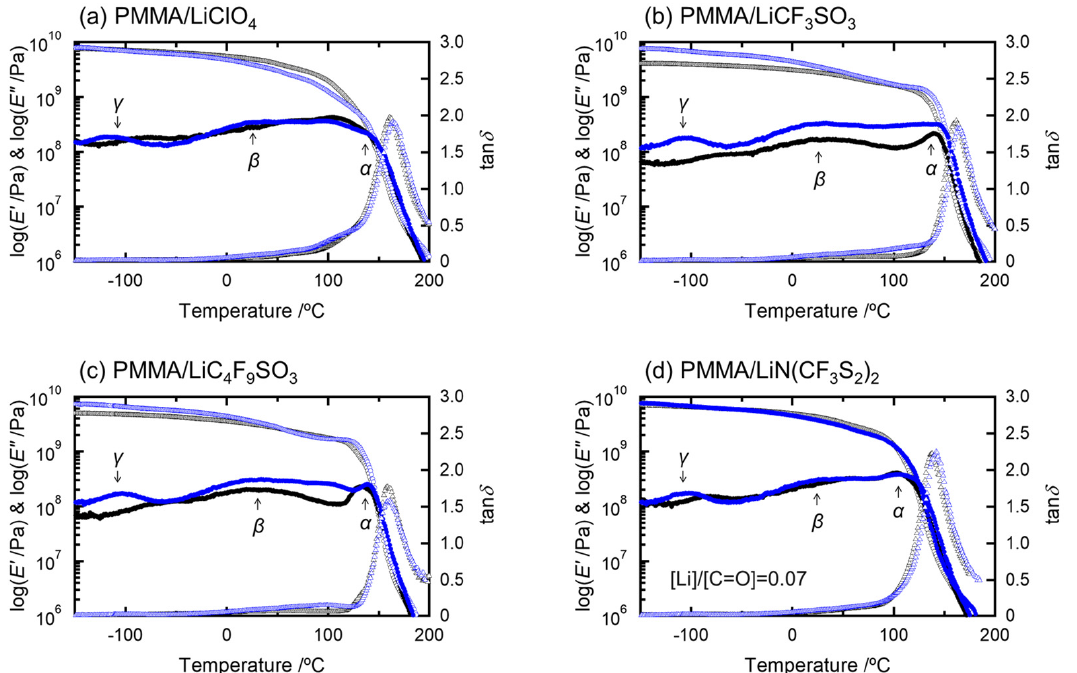
Figure 1. Temperature dependence of dynamic mechanical properties of dried (black) and water- absorbed (blue) samples: PMMA doped with ( a ) LiClO 4 , ( b ) LiCF 3 SO 3 , ( c ) LiC 4 F 9 SO 3 , and ( d ) LiN(CF 3 SO 2 ) 2 , with a 0.07-molar ratio salt concentration. α relaxation around at 100–120 ◦ C is ascribed to the glass transition; β relaxation around at − 50–100 ◦ C is to the relaxation of side groups; γ relaxation around at − 150– − 50 ◦ C is to the relaxation of local relaxation